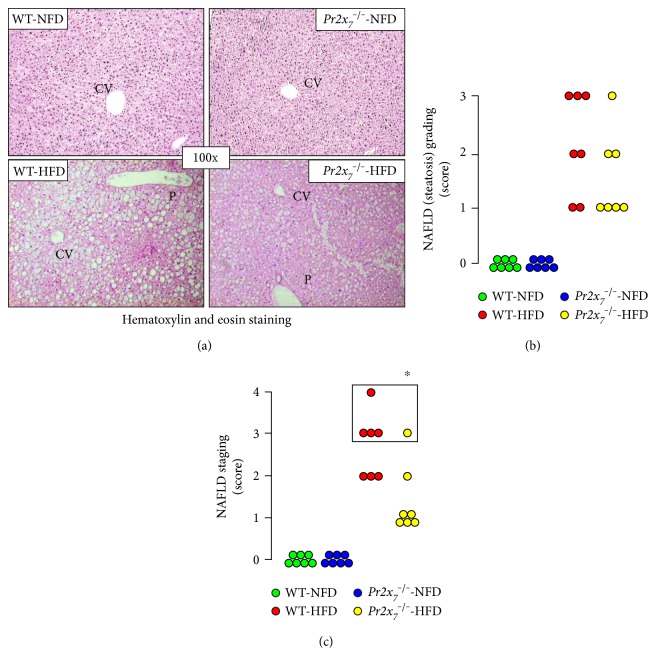
NAFLD grading and staging. Hematoxylin and eosin staining of liver sections from representative animals ((a); original magnification 100x) and NAFLD (steatosis) grading (b) and staging (c) in NFD- and HFD-fed WT and Pr2x7−/− mice (n = 7 per group). P = portal area; CV = centrolobular vein. The box indicates mice fulfilling NASH criteria. ∗P < 0.05 versus WT mice. NAFLD = nonalcoholic fatty liver disease; NFD = normal-fat diet; HFD = high-fat diet; WT = wild type; Pr2x7−/− = knockout for purinergic receptor 2X7 gene; NASH = nonalcoholic steatohepatitis.